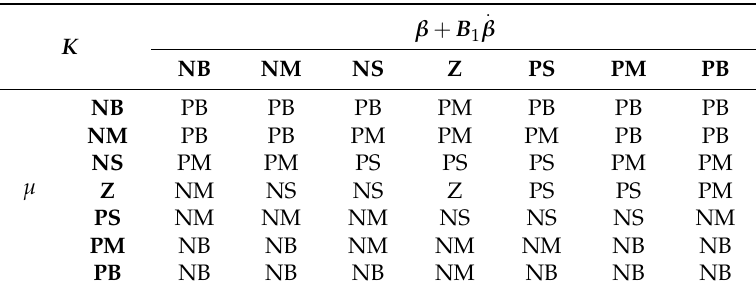
Table 1. Fuzzy rules of correction coefficient K .